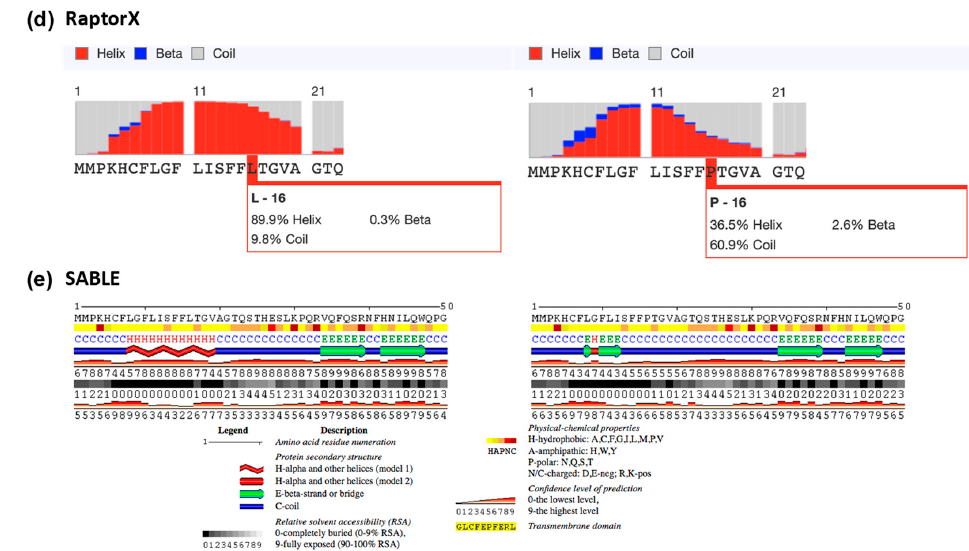
Figure A4. Signal peptide prediction in the Leu16 and Pro16 variant IL-22BP proteins. SignalP 5.0, PrediSi and Signal-3L predicted the cleavage site for both wild-type and p.Leu16Pro mutant to be the 21st residue of the signal peptide. Panels ( a – c ) show cleavage sites from SignalP 5.0, PrediSi and Signal-3L, respectively. Panels ( d , e ) represent the secondary structure predictions from RaptorX and SABLE, respectively.